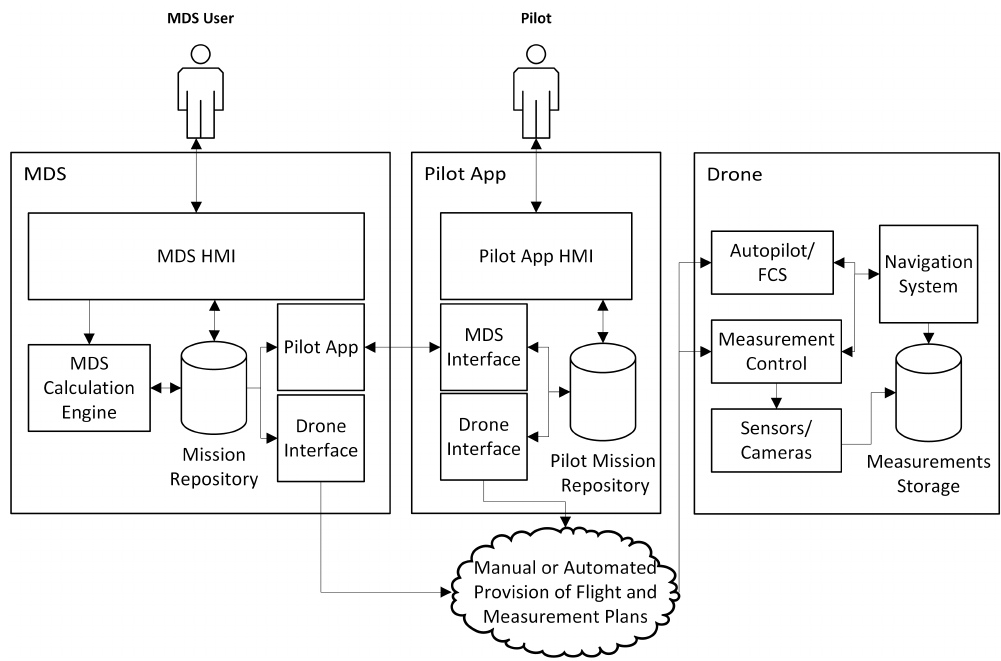
Figure 1. Mission Setup